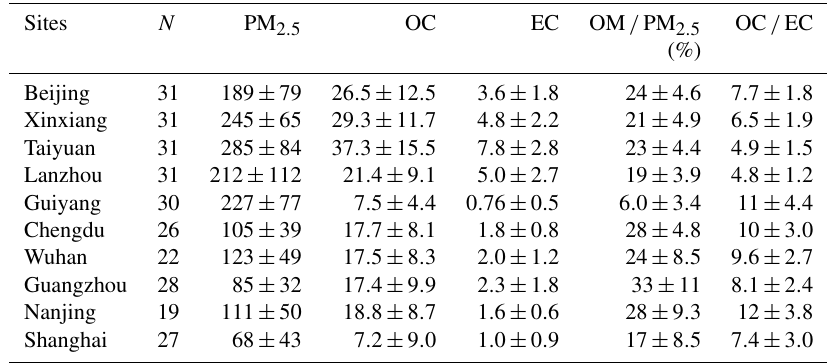
Table 1. The PM 2 . 5 , OC and EC data used in this study (average ± standard deviation; µgm − 3 ). Sites N PM 2 . 5 OC EC OM / PM 2 . 5 OC / EC